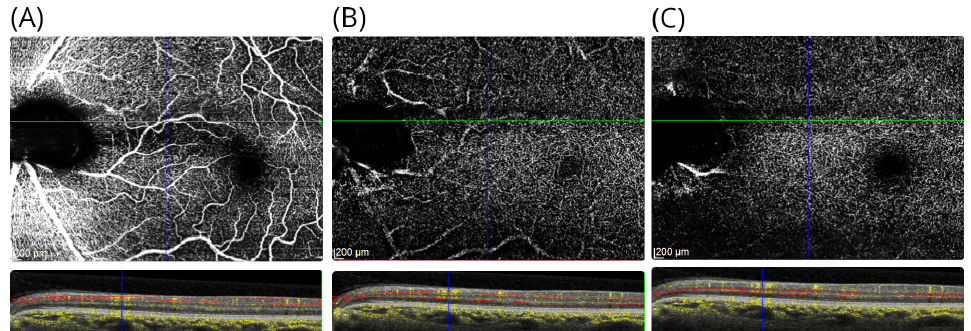
Figure 3. OCTA in patient #1. The OCTA shows the ( A ) the inner retinal vasculature at level of the RNFL, ( B ) the superficial vascular plexus above the INL, and ( C ) the deep vascular plexus located below the INL. For each OCTA, the layer segmentation (red dashed lines) and OCTA signal (yellow) are shown. Note that there are shadowing artefacts from the larger inner retinal vessels in subfigures ( B , C